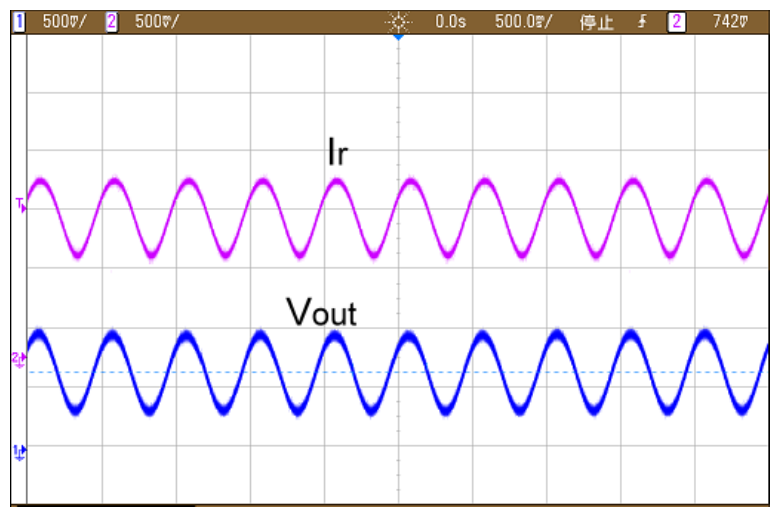
Figure 12. The output voltage with input